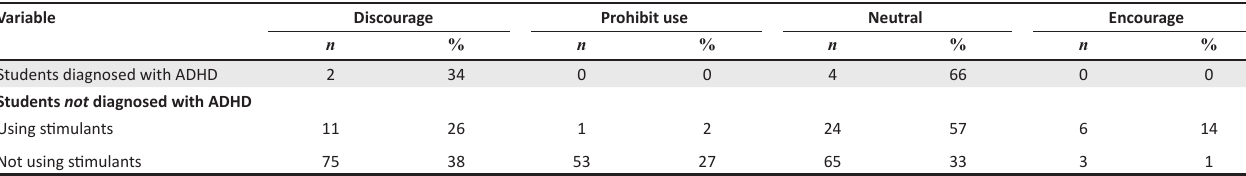
TABLE 3: Students’ opinion on frequency of peer stimulant use. † Variable None Only a few Many Most Do not know Students diagnosed with ADHD Students not diagnosed with ADHD Using stimulants Not using stimulants